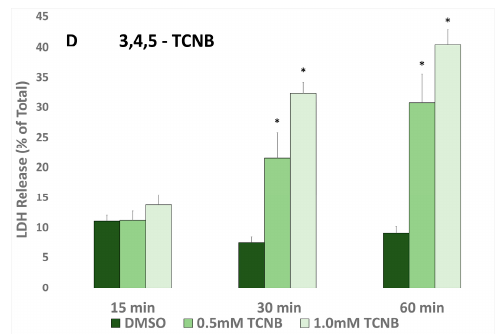
Figure 2. Cytotoxic effects of ( A ) 2,3,4-TCNB, ( B ) 2,4,5-TCNB, ( C ) 2,4,6-TCNB and ( D ) 3,4,5-TCNB in isolated renal cortical cells (IRCC). An asterisk (*) indicates significant difference from the appropriate dimethyl sulfoxide (DMSO) control group value, p < 0.05.